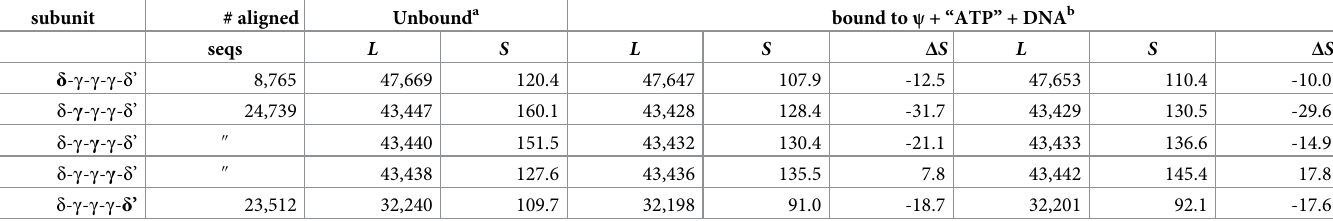
Table 8. S as a measure of structural biological relevance for the bacterial DNA clamp loader complex based on a minimum distance of 3 Å and a maximum of 5 Å . subunit # aligned Unbound